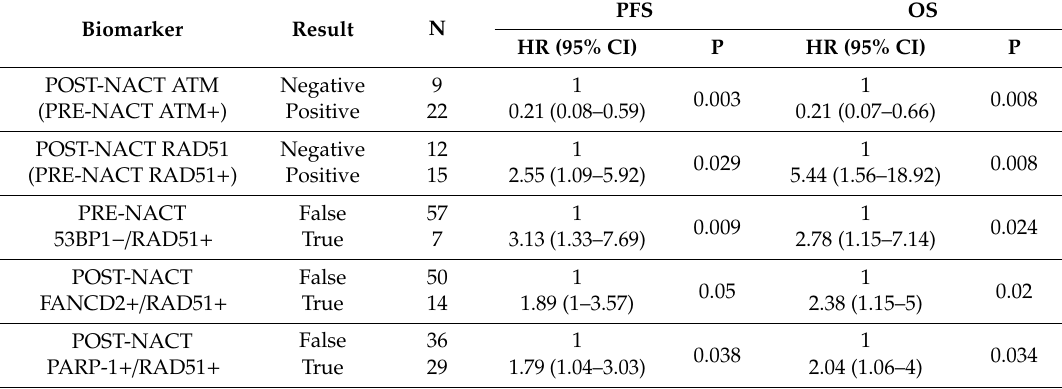
Table 4. Multivariate analysis of combined biomarkers.